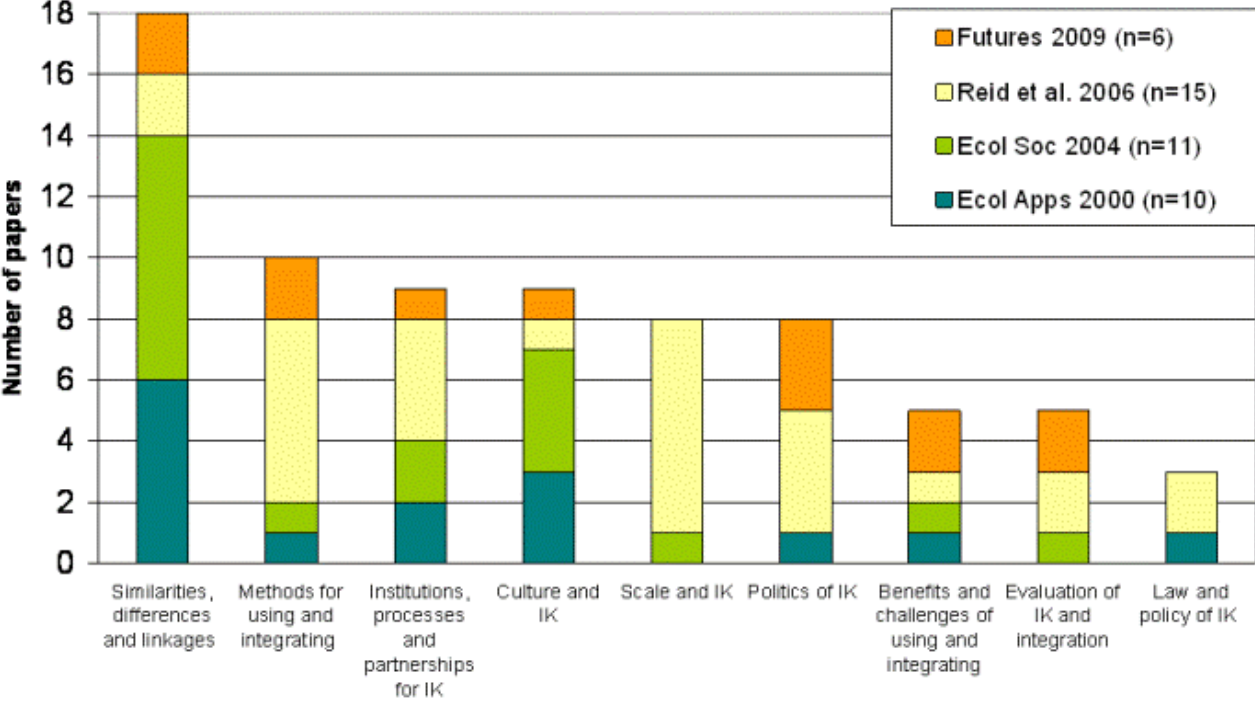
Fig. 1. Themes identified in the reviewed literature. Introductions and synthesis chapter of Reid et al. (2006) were excluded from analysis. IK = indigenous